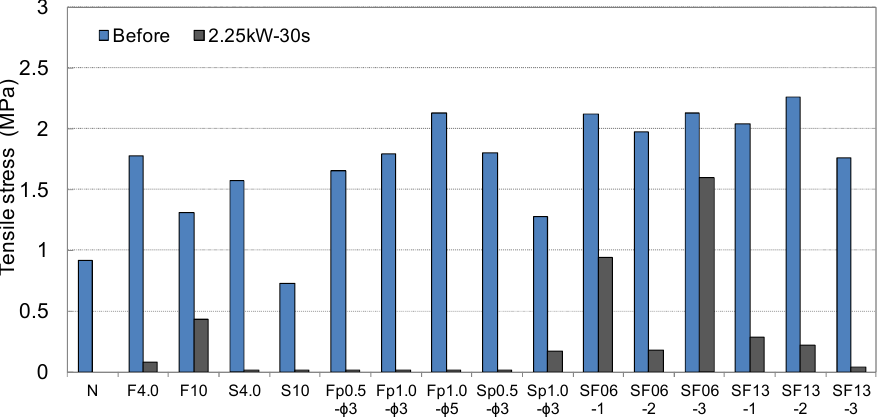
Figure 22. Residual tensile bond strength after induction heating of the cementitous joint using a conductive